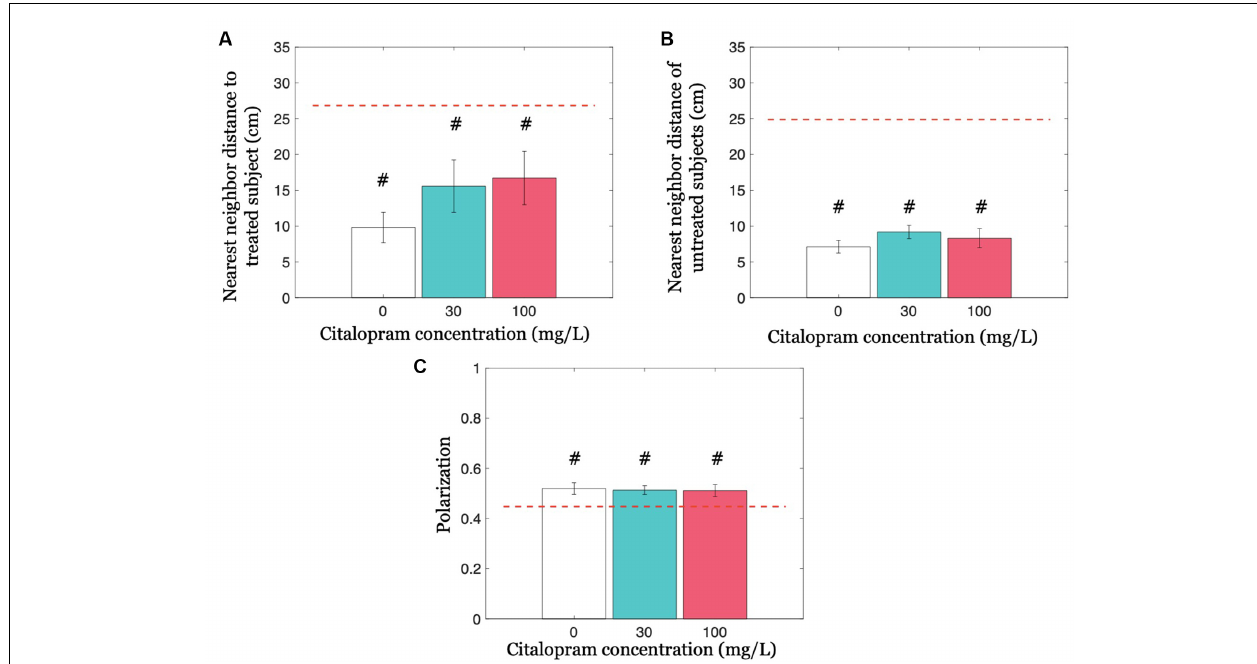
FIGURE 4 | Group cohesion and coordination quantified as nearest neighbor distances and polarization, respectively. (A) The nearest neighbor distance to the treated subject for each Citalopram concentration. (B) Nearest neighbor distance of untreated subjects for each Citalopram concentration. (C) Polarization as a function of Citalopram concentration. # p < 0.050 compared to the chance value, denoted by the red dashed-line.